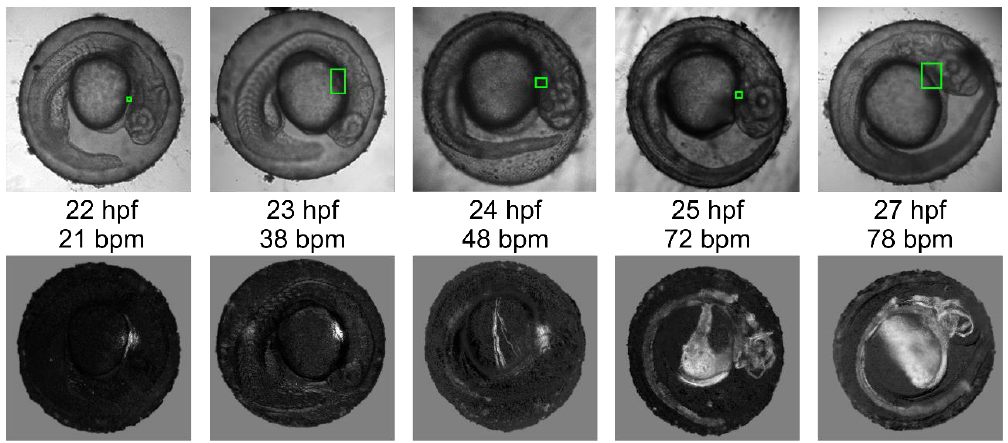
Figure 5. Calculated vessel images (green rectangles indicate the detected heart area).